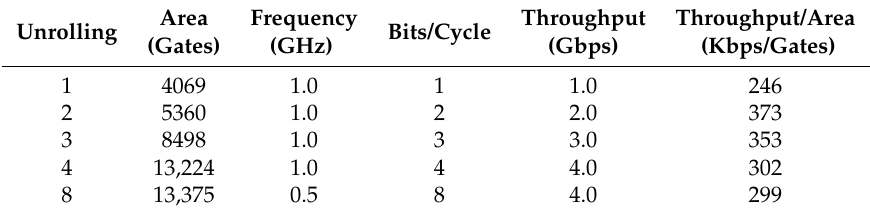
Table 2. MICKEY 2.0 synthesis results for highest frequency (65 nm).